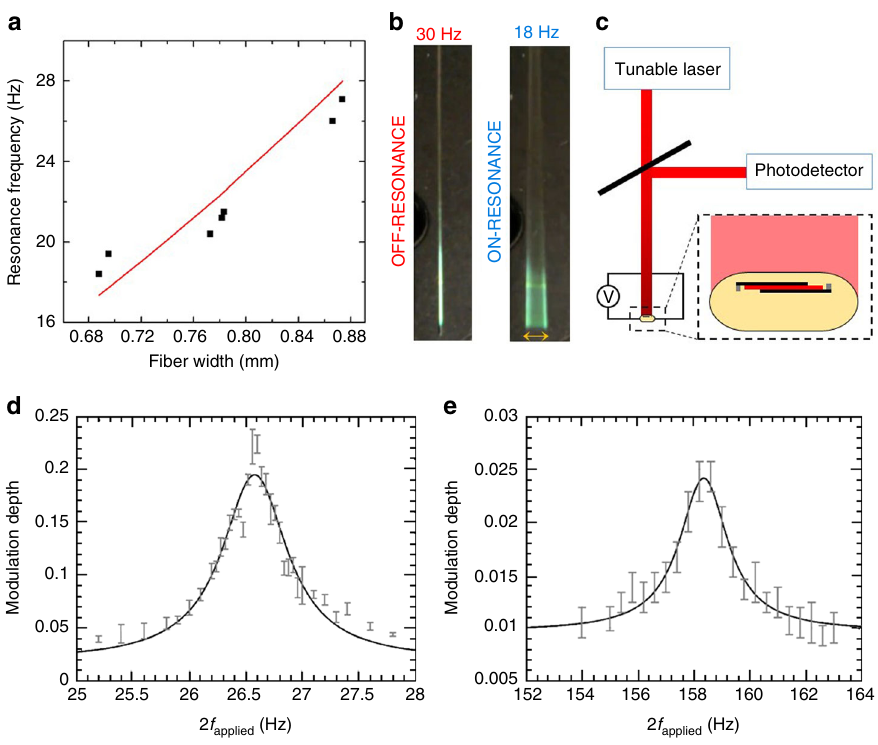
Fig. 3 Electrostrictive fi bre resonances. a Fiber width is utilized to adjust resonance frequency of the fi bre MEMS. b Amplitude of oscillation is shown both for on and off-resonance frequency points. c Optical setup to measure amplitude modulation under applied voltage and driving frequency. d Modulation depth measured in the vicinity of the fi rst harmonic, approximately 26.6 Hz. Solid line is a fi tted Lorentzian curve. e Modulation depth measured in the vicinity of the second harmonic, ~158.3 Hz. Solid line is a fi tted Lorentzian curve. Error bars in d , e represent a width of one standard deviation about the mean of the measured sample set, which contains three measurements for each frequency